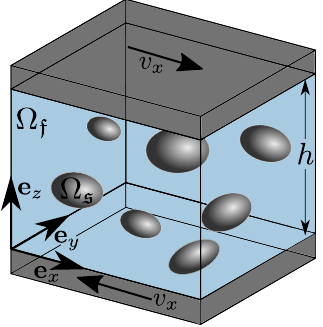
Figure 10. Sketch of simulated boundary value problem (BVP) of shear induced suspension flow in a channel of height h in e z -direction. The simulation domain contains periodic boundary conditions in direction of e x and e y . Upper and lower wall particles are moved with a constant velocity v x = 0.005m/s corresponding to an input shear rate of ˙ γ = 2 | v w | / h = 0.5 s − 1 .